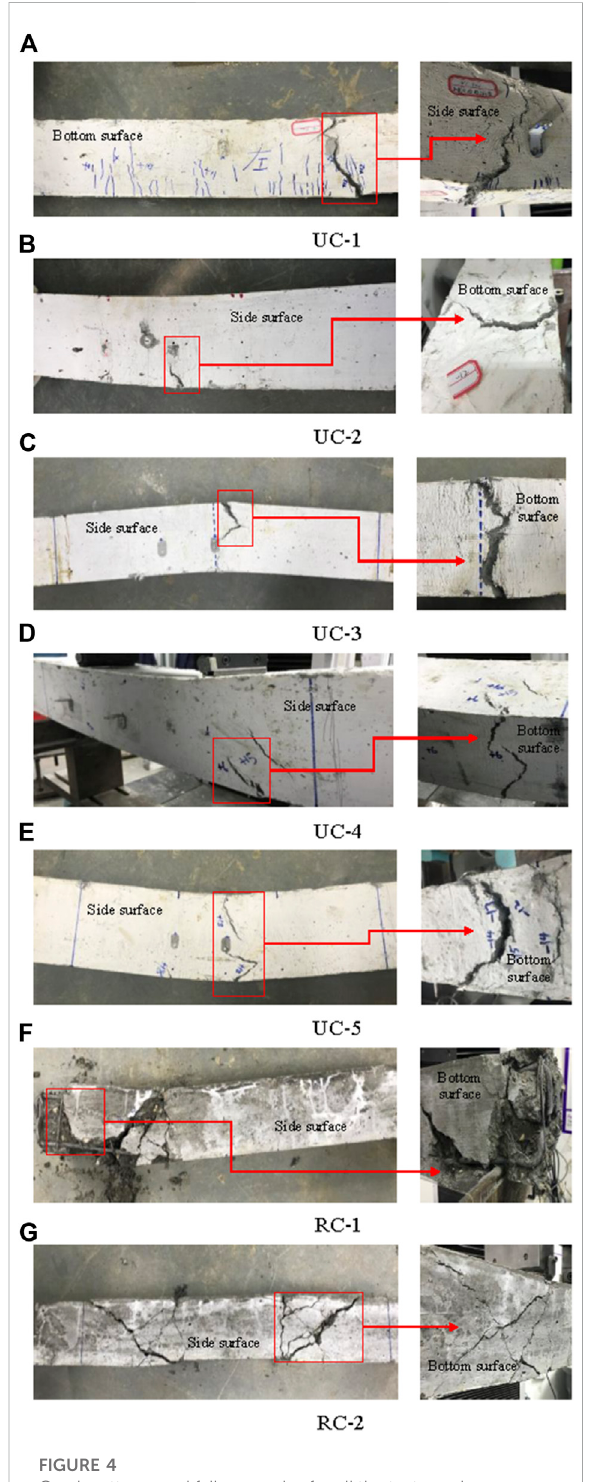
FIGURE 4 Crack patterns and failure modes for all the test